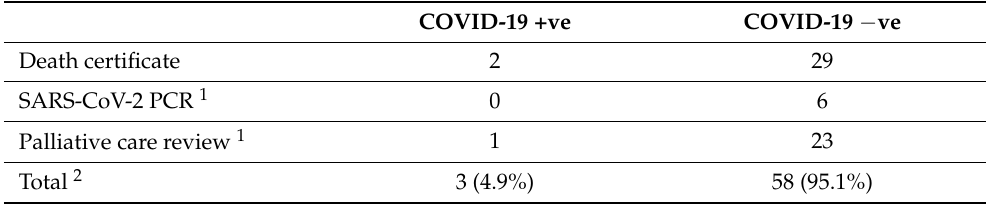
Table 2. Information sources used to infer COVID-19 status at death for the “pandemic”